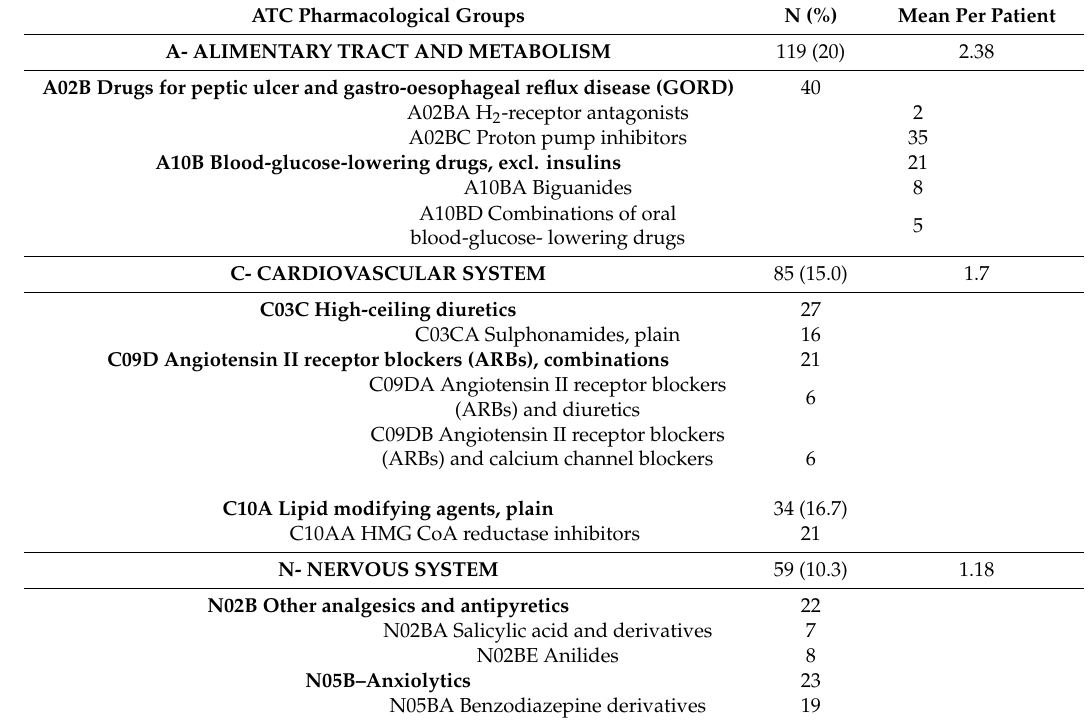
Table 2. Use of medicines in Anatomical Therapeutic Classification (ATC) pharmacological groups A, C, and N.